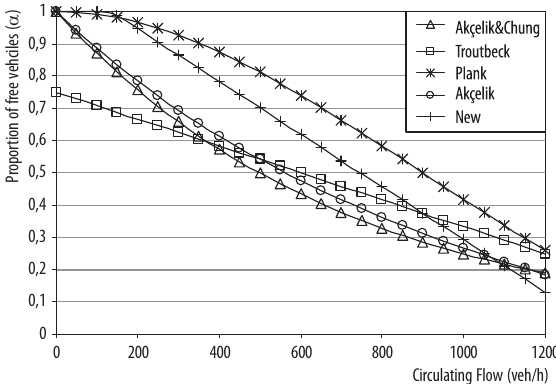
Fig. 1. Comparison of diff erent models for the proportion of free vehicles in single-lane traffi c